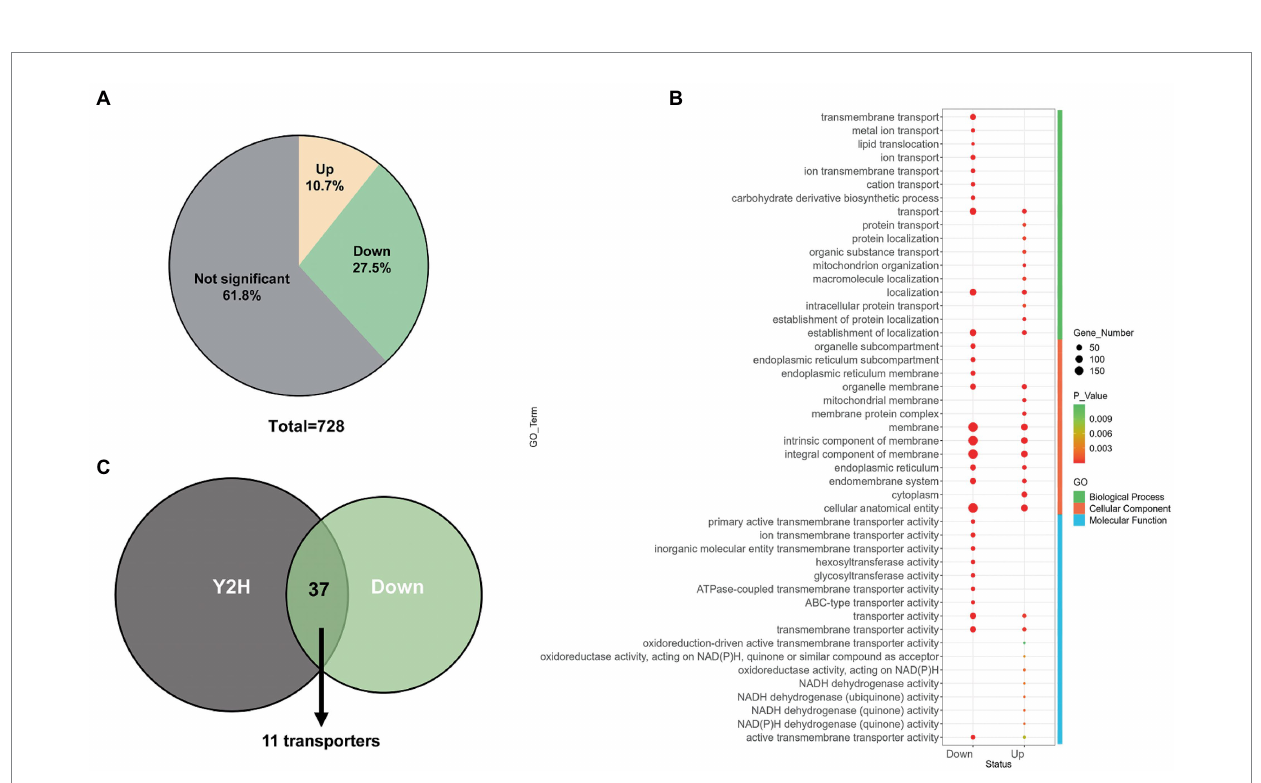
FIGURE 5 Membrane proteomics analysis of the DEL-Erv14 strain. (A) Venn diagram of the proportions of significantly up- and down-regulated membrane proteins in the DEL-Erv14 strain compared to the control strain. The significant difference was defined as log 2 FC greater than 1 or less than − 1, and the value of p less than 0.05. (B) Functional clustering for up- and down-regulated membrane proteins. (C) Venn diagrams of the number of overlapping transmembrane proteins between the ERV14 interactome and the down-regulated proteins identified in the DEL-Erv14 membrane